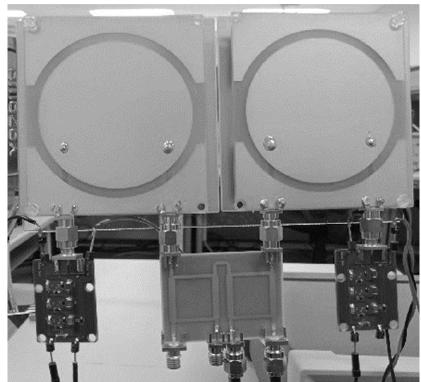
Figure 9. Implementation of the prototype CP Antenna with 2 × 4 Hybrid Coupler for Hybrid Electromagnetic Solar Energy Harvesting and wireless sensor.